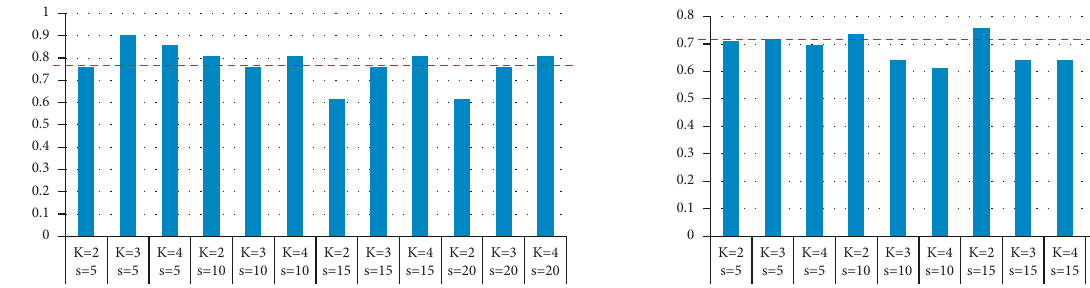
Figure 5: Sensitivity of CBCD on GS with a threshold 0.005.